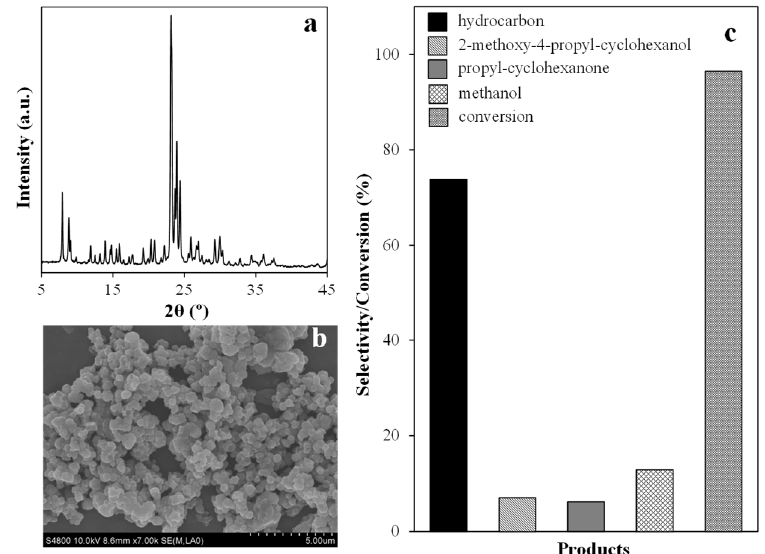
Figure 9. The XRD spectrum ( a ) and SEM image ( b ) of ZSM-5 synthesized from silica spheres, and the catalytic performance of APR hydrodeoxygenation over Pd/C-based HZSM-5 catalysts ( c ).